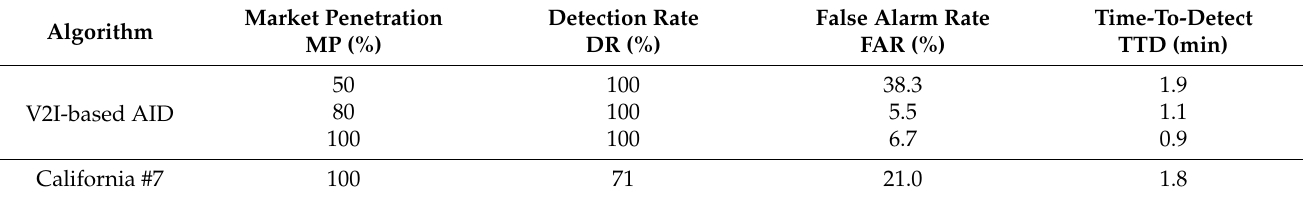
Table 3. Performance measures for V2I-based AID and California #7